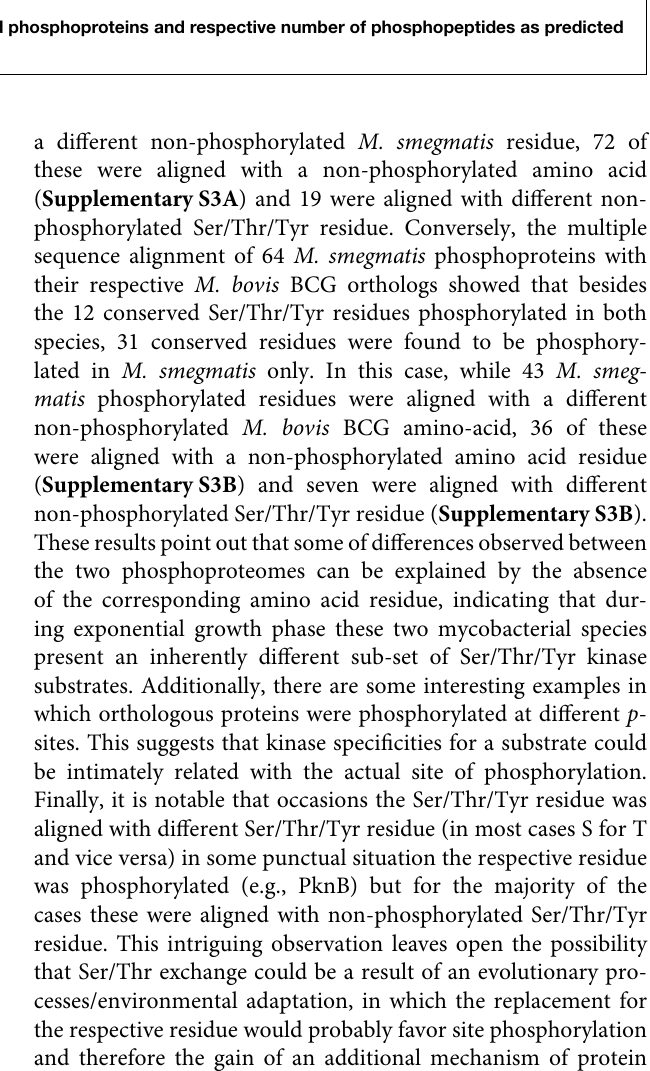
which 106 were confidently localized (LP = 0.75; PEP = 0.01)